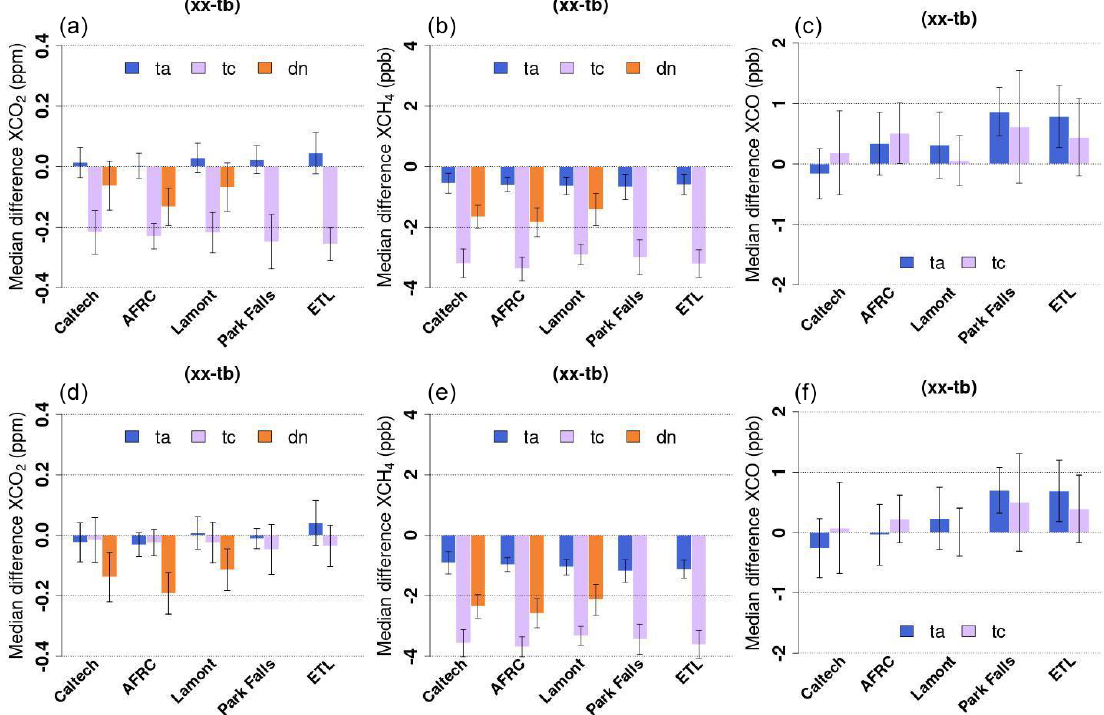
Figure 6. These figures show the median differences between the 10min averaged EM27/SUN XCO 2 (in ppm) and XCH 4 and XCO (both in ppb) from coincident EM27/SUN measurements collected throughout the 2018 field campaign at each TCCON site before applying the instrument-to-instrument bias correction. The colour bars show the median biases of each EM27/SUN (ta, tc, and dn) relative to the tb EM27/SUN instrument at each stop during the field trip. Panels (a) – (c) show GGG2014 and panels (d) – (f) GGG2020 results, respectively. The error bars on each colour bar represent the median absolute deviation in the 10min averaged biases.